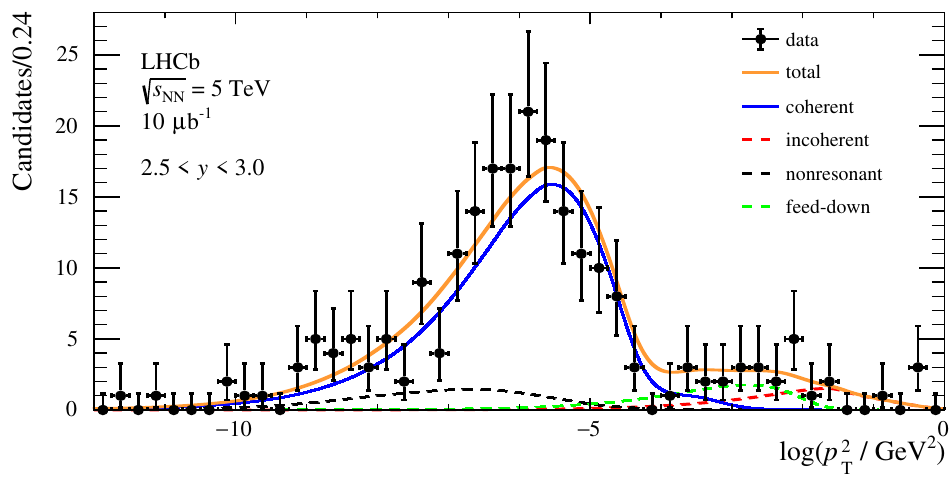
Figure 3 . The log( p 2 ) distribution of dimuon candidates in the interval 2 . 5 < y < 3 . 0 , with p T T given in GeV, after all requirements have been applied. The solid orange line represents the com- bined fit to data; the solid blue line shows the coherent contribution; the incoherent component is displayed by the dashed red line; and the dashed green (black) line shows the feed-down (nonreso- nant) components.